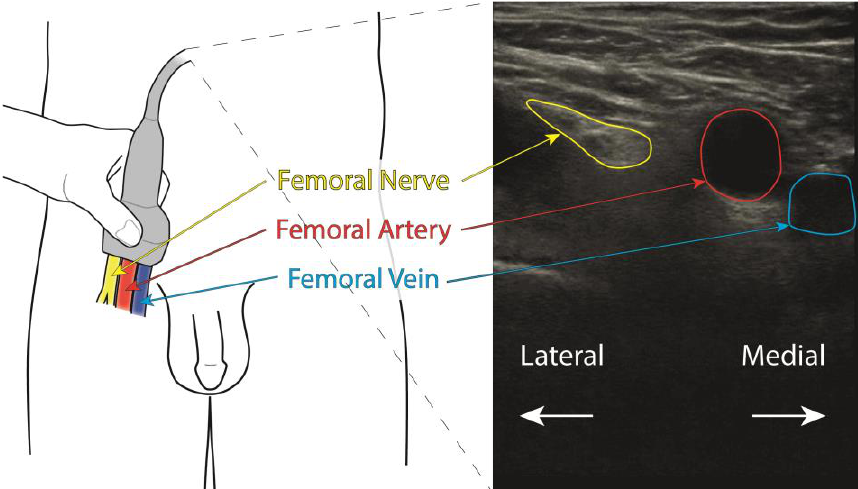
Figure 1. Schematic view of the anatomical situation (left), together with the approximate placement of the ultrasound transducer proximal to the nerve bifurcation. Locations of the femoral nerve, artery and vein are indicated with arrows and text in yellow, red, and blue, respectively. To the right, an example ultrasound image is shown, with the anatomical structures indicated in the same colors.